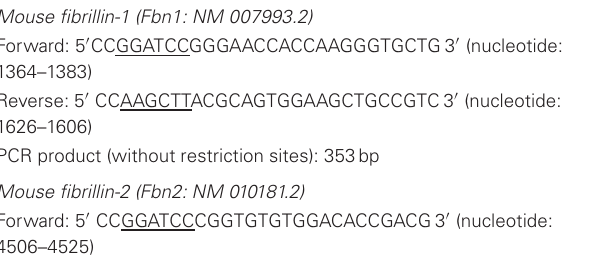
Table 1 | Primers used for generation of gene-specific RNA probes for in situ